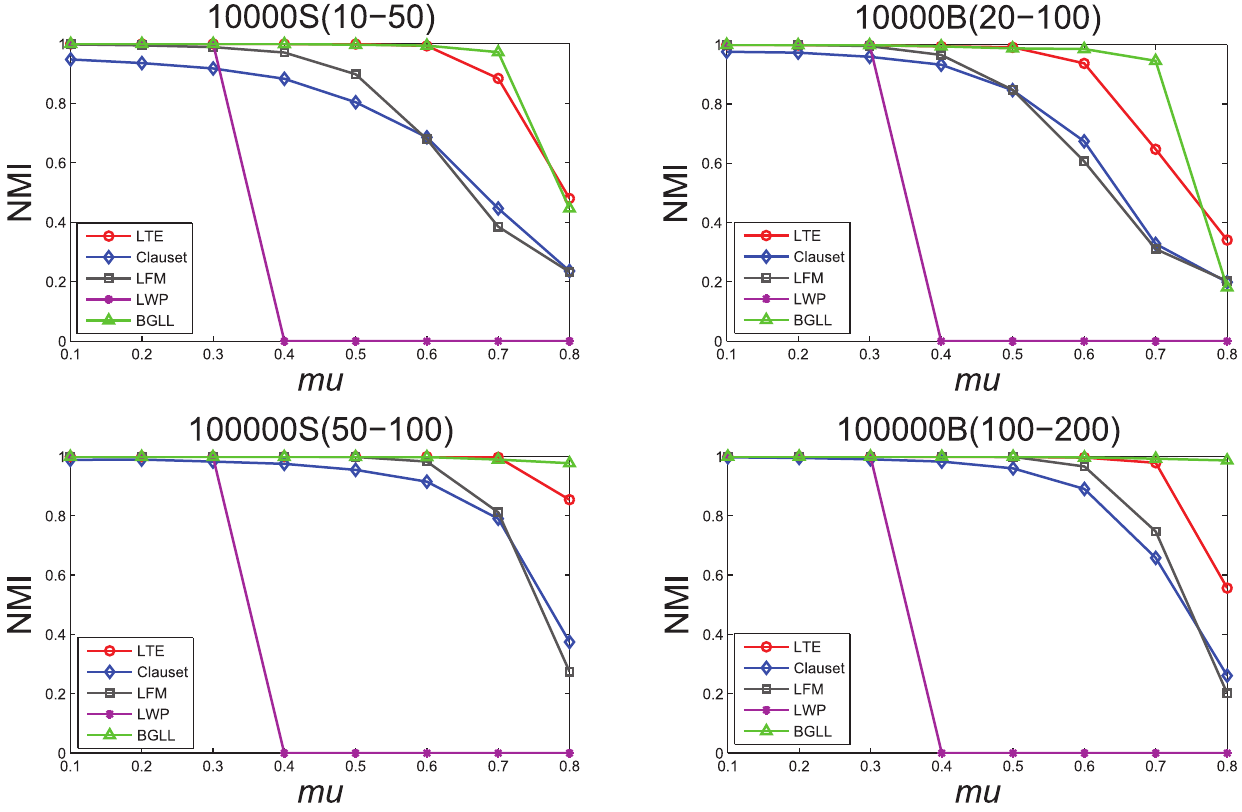
Figure 7. Test of the accuracy of different community detection algorithms on LFR benchmark networks. doi:10.1371/journal.pone.0023829.g007 PLoS ONE |